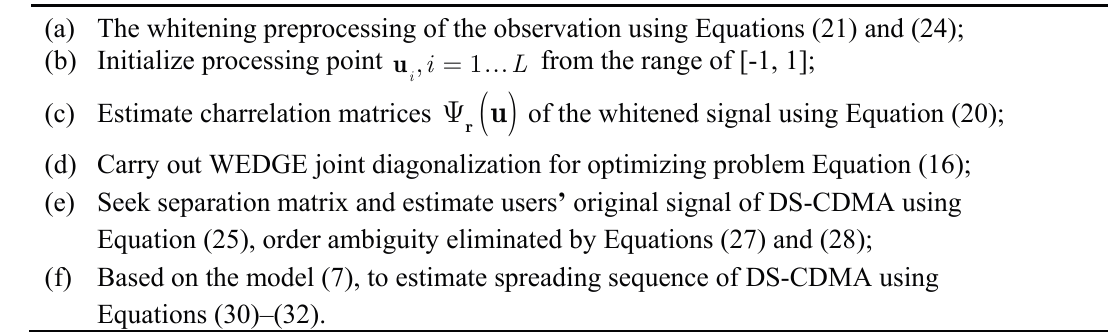
Table 2. Blind Adaptive Detector for DS-CDMA